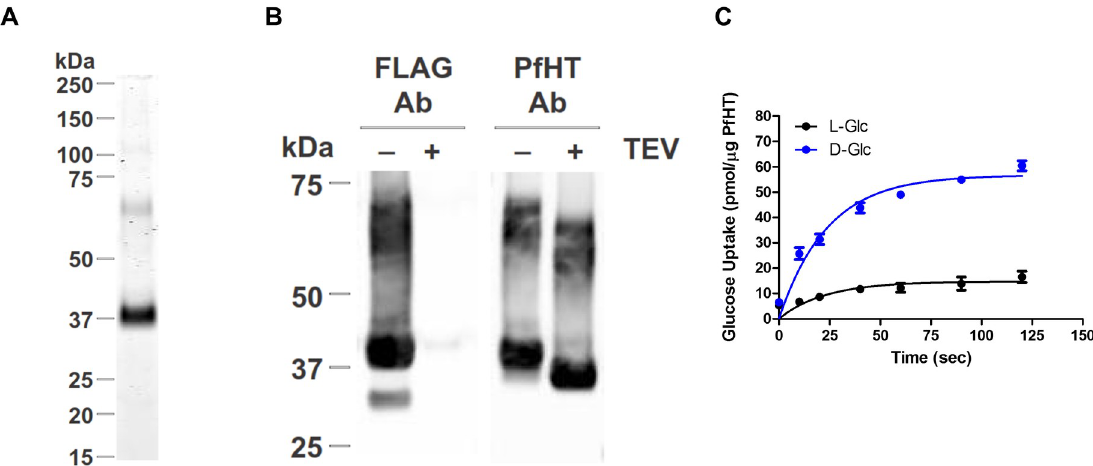
Fig 7. PfHT mediated uptake of [ 3 H]-D-glucose and [ 3 H]-L-glucose into liposomes. Purified PfHT protein ( ± FLAG tag) was reconstituted into eggPC/POPA/POPE (70:15:15) liposomes. A) SDS-PAGE of PfHT liposomes stained with Blue Bandit protein stain. B) Immunoblot analyses of PfHT liposomes using an anti-FLAG antibody (Ab) and a C-terminal PfHT specific antibody. ( ± ) TEV indicates whether the FLAG tag of purified FTPfHT protein was cleaved off with TEV protease prior to the reconstitution into liposomes. C. Saturable, zero-trans uptake of [ 3 H]-D-glucose into PfHT (-FLAG) liposomes (blue) compared to nonspecific uptake of [ 3 H]-L-glucose (black). Uptake data were fitted using nonlinear regression analysis (GraphPad 6.0). Data are expressed as means ± SEMs (n =